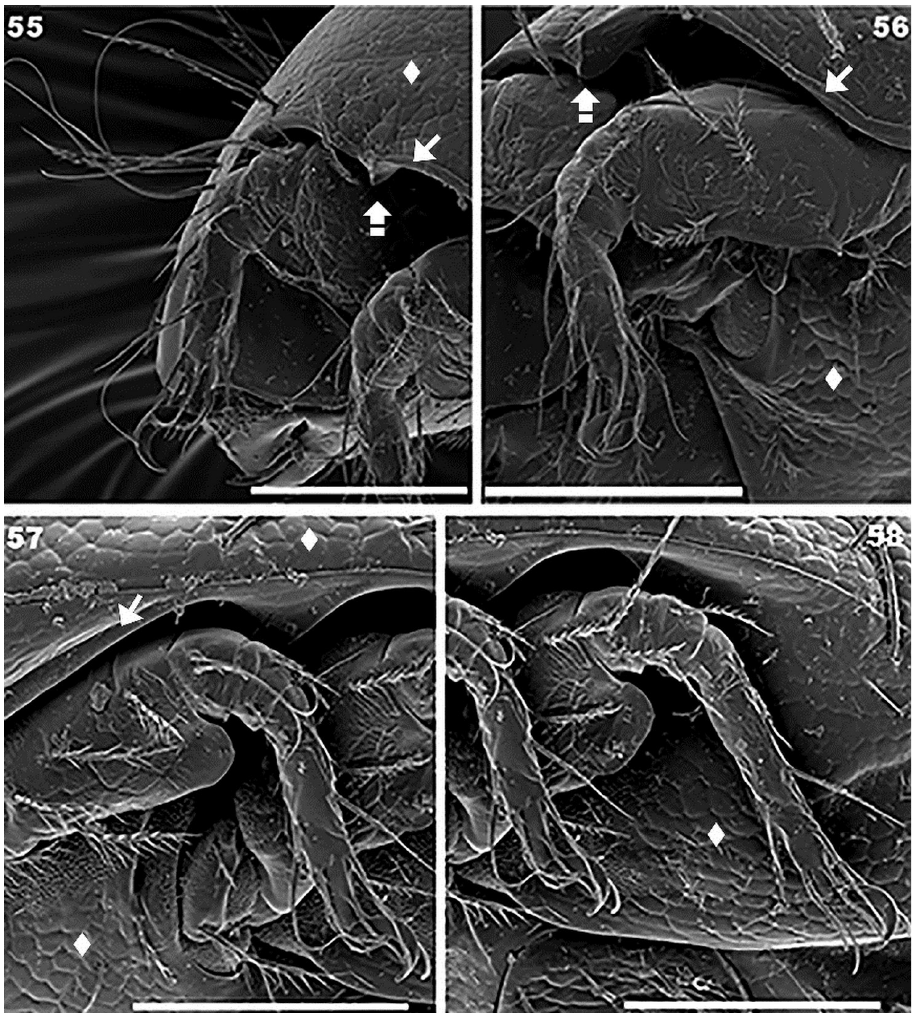
Figures 55–58. Torpacarus eidikoterai sp. n. Adult female with cerotegumental layer. SEM micrographs. 55 leg I, paraxial view 56 leg II, ventral paraxial view 57 leg III, paraxial view 58 leg IV, paraxial view. Scale bars: 100 μm ( 55 ); 100 μm ( 56 ); 100 μm ( 57 ); 100 μm ( 58 ).